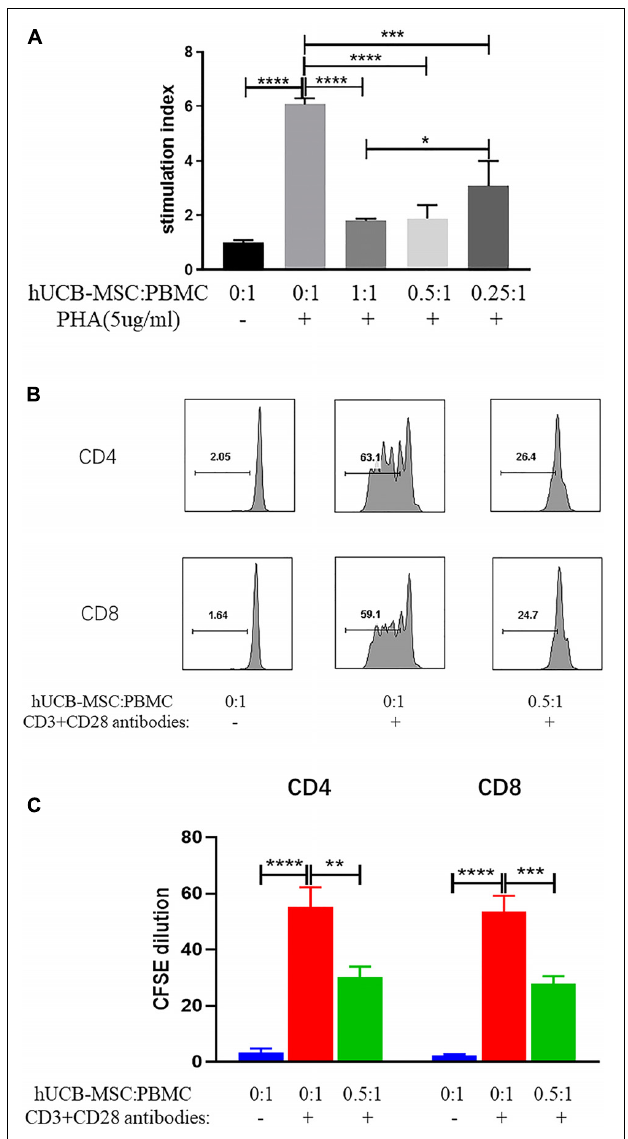
FIGURE 2 | hUCB-MSCs are capable of suppressing T cell proliferation in vitro . (A) Inhibitory effects of hUCB-MSCs on PHA-stimulated PBMC proliferation. In the presence or absence of PHA at 5 µ g/ml, 1 × 10 5 PBMCs were cultured alone or in combination with hUCB-MSCs for 4 days, and then counted using CCK-8. * p < 0.05, *** p < 0.001 and **** p < 0.0001. The results showed are from more than three independent experiments. (B,C) 1 × 10 5 CFSE-labeled CD4 or CD8 cells were stimulated with 10 µ g/ml plate-bound CD3 antibodies and 1 µ g/ml CD28 antibodies for 4 days. At the beginning of the stimulation period, add half number of hUCB-MSCs to the relevant wells. Flow cytometry was used to observe proliferation of CD4 and CD8 cells. ** p < 0.01, *** p < 0.001 and **** p < 0.0001. The results showed are from more than three independent